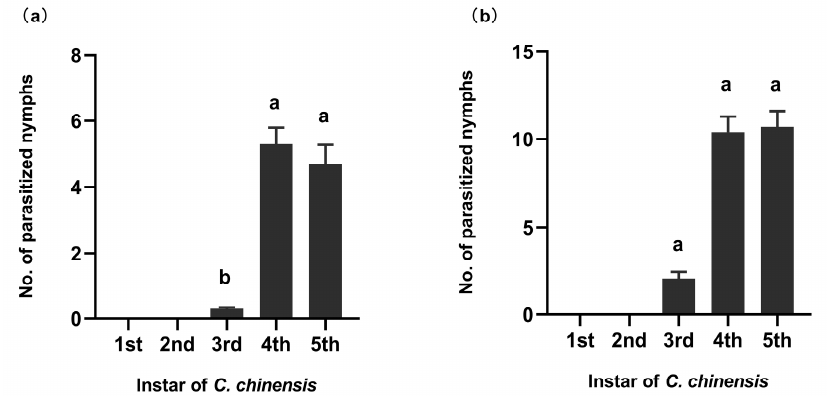
Figure 1. Preference of Psyllaephagus sp. to Cacopsylla chinensis among different nymphal stages. ( a ) Choice test; ( b ) No-choice test. Black bars ( ± standard deviation) followed by different lowercase letters indicate significant differences among instars ( p < 0.001, Kruskal–Wallis test).